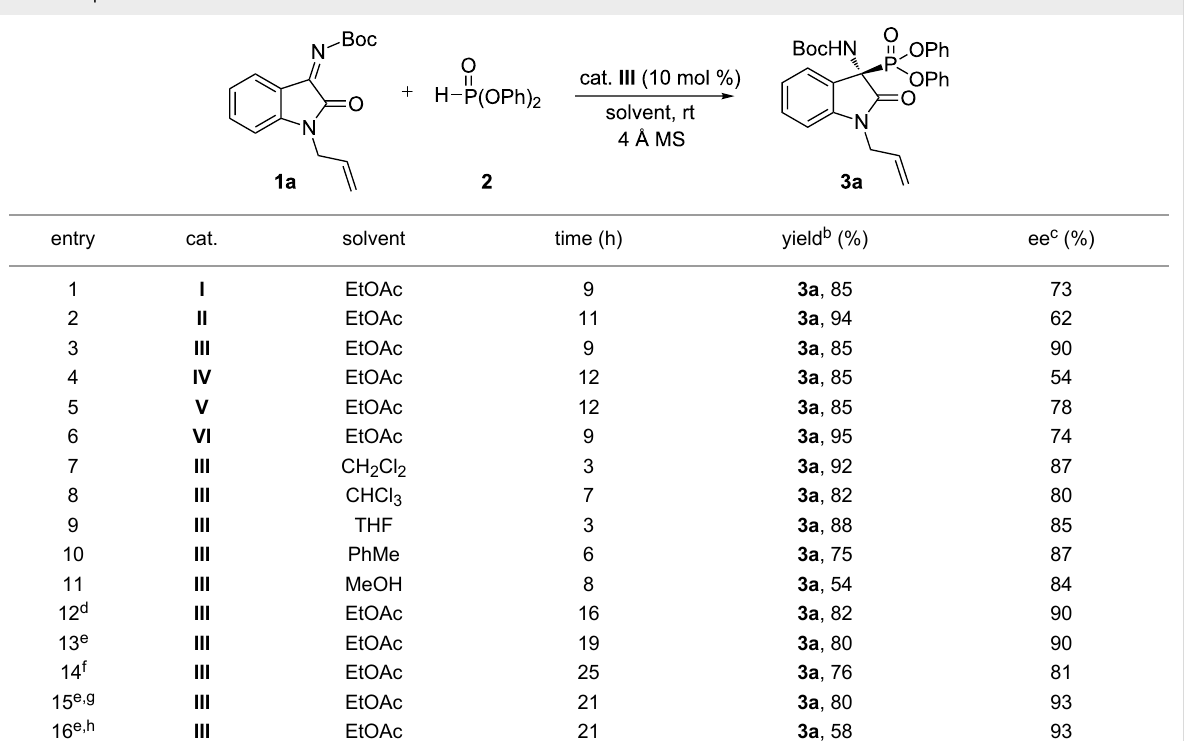
Table 1: Optimization of the reaction conditions. a